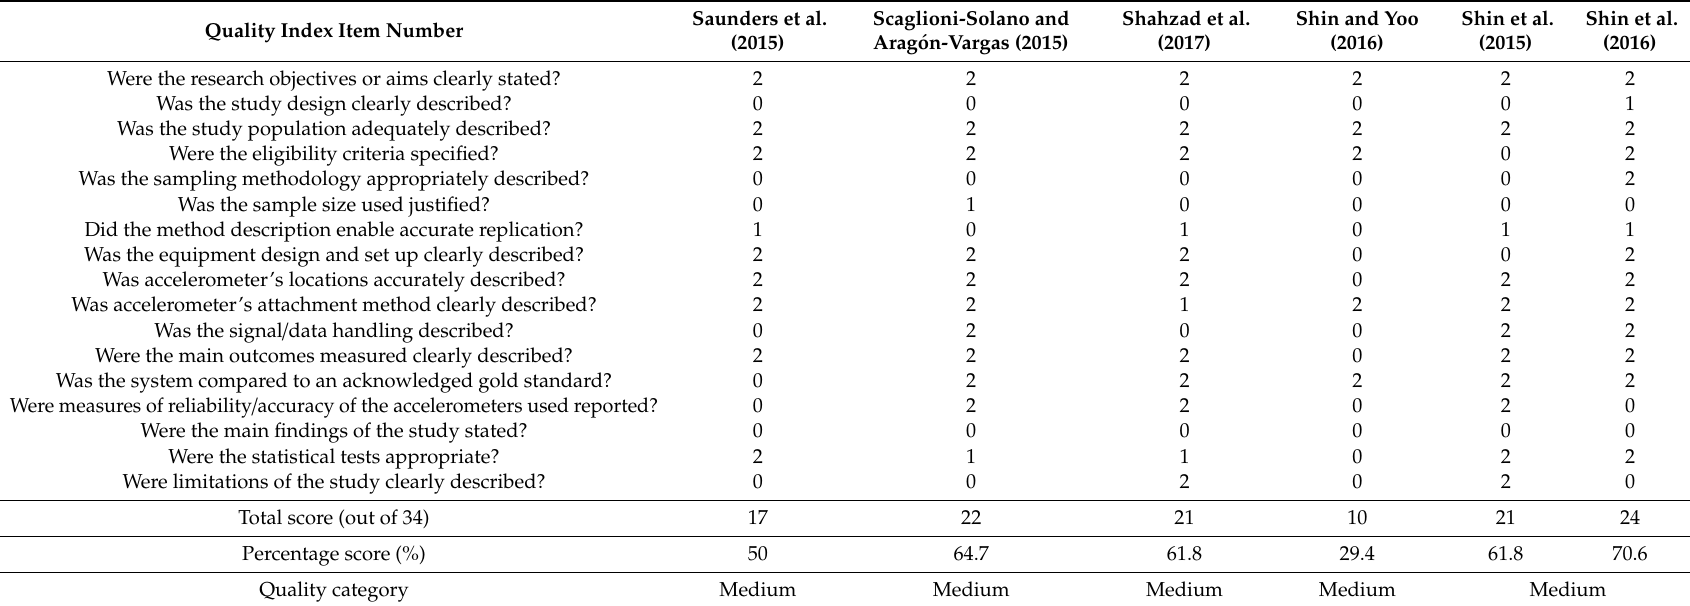
Table A2. Quality assessment of included